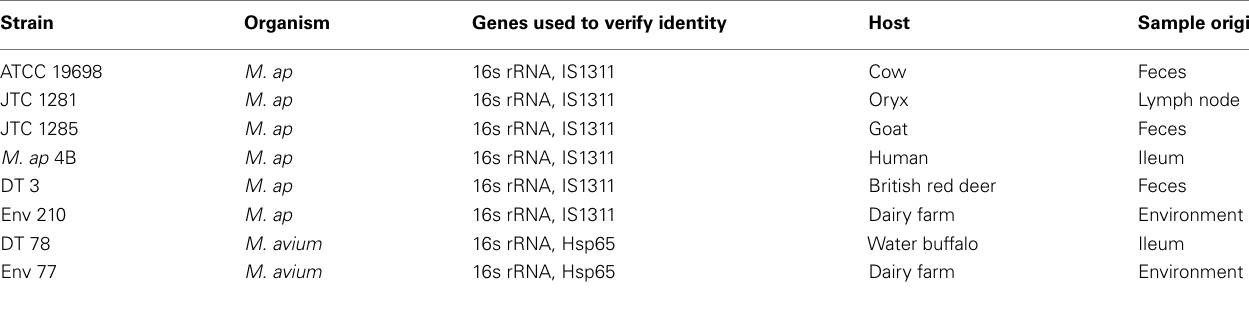
Table 1 |A list of mycobacterial isolates used in this study. Strain